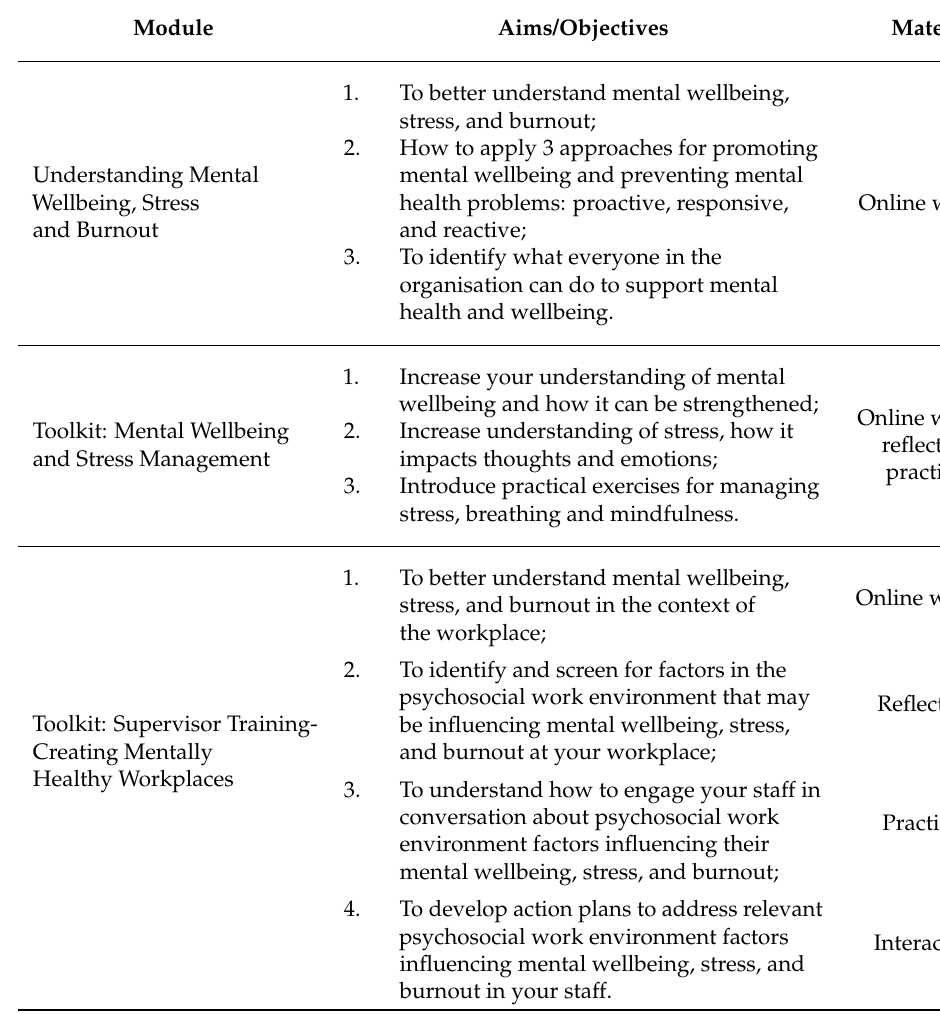
Table 1. Overview of the aims, content, and delivery of MENTUPP components.